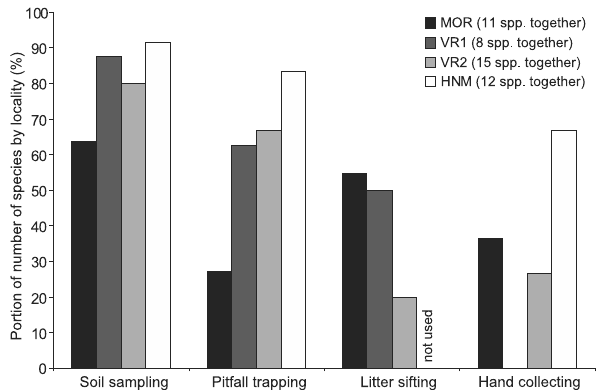
Figure 1. Comparison of relative efficiency of methods for centi- pede collection. Per cent proportion of species found by individual methods in studied localities.